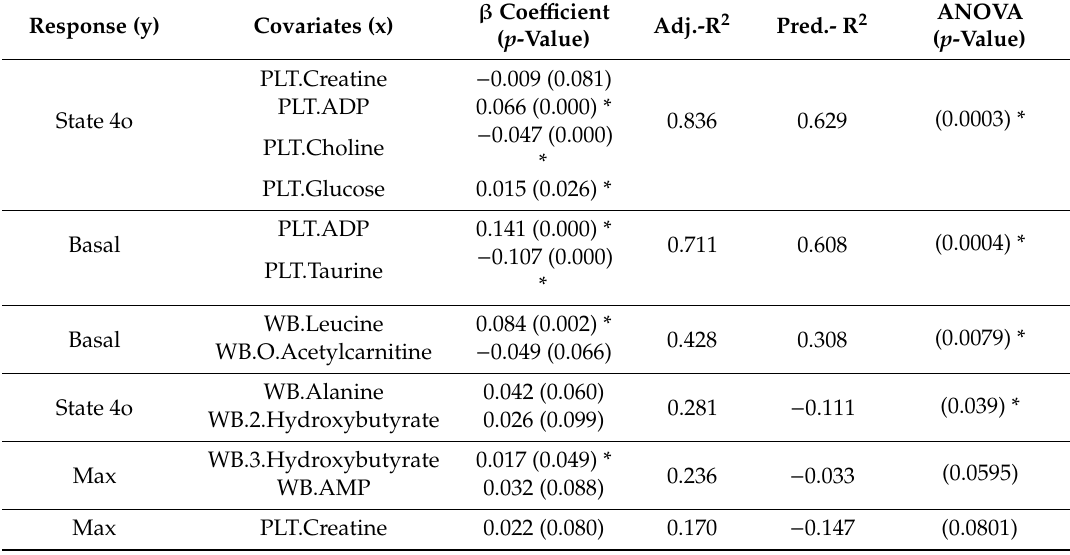
Table 3. Multiple Linear Regression